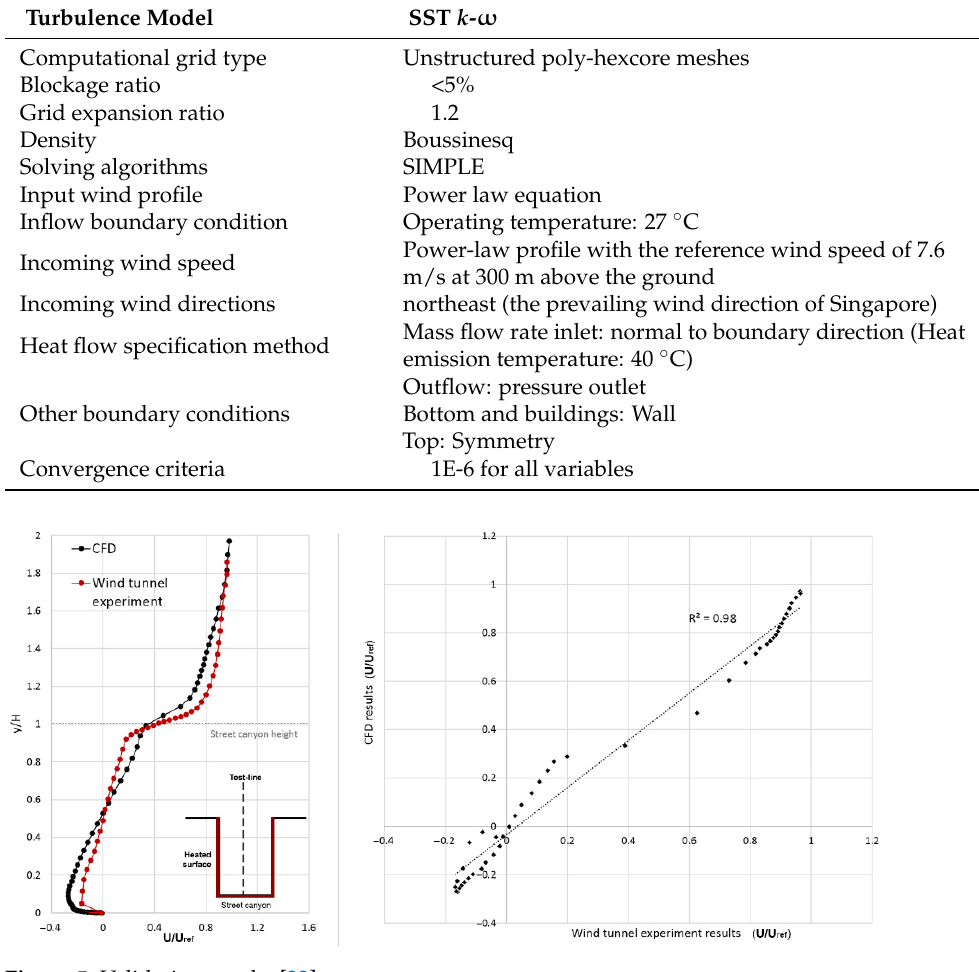
Figure 6. Examples of locations and geometries of heat sources regarding different AC types and building functions (AC—air conditioning).